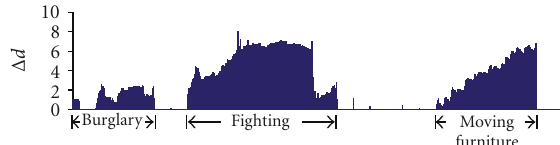
Figure 8: Excessive distances Δ d of the three abnormal events in the laboratory: burglary, fighting and moving furniture out of the room. (Note that the duration scales in the x -axis of both Figures 7 and 8 are the